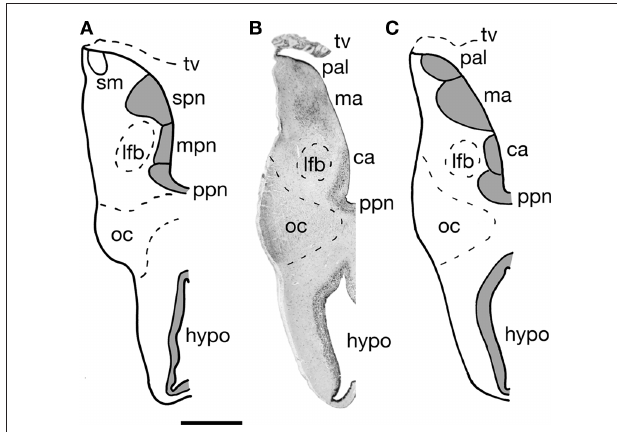
Figure 3 | A transverse section through one half of the telencephalon impar of the Comoran coelacanth. (A) Cell groups as interpreted by Nieuwenhuys (1965). (B) A Nissl-stained section from the present study showing the histology. (C) Cell groups as interpreted in the present study. Bar scale = 1 mm. ca, Central amygdalar nucleus; hypo, hypothalamus; lfb, lateral forebrain bundle; ma, medial amygdalar nucleus; mpn, magnocellular preoptic nucleus; oc, optic chiasm; pal, pallium; ppn, parvocellular preoptic nucleus; stria medullaris; spn, superior preoptic nucleus; tv, transverse